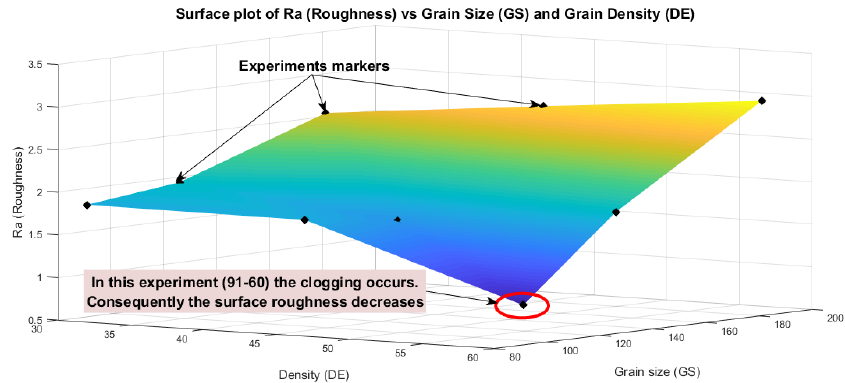
Figure 2. Surface plot of Ra vs. grain size and density of abrasive grains.